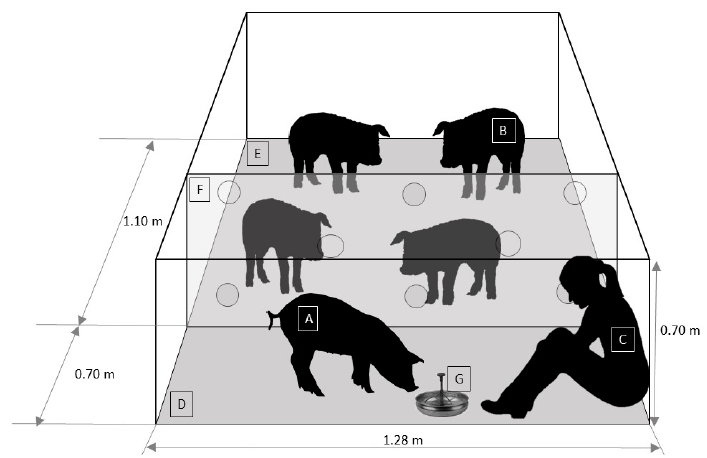
Figure 1. Schematic representation of the pen (front view) during the gentle handling session. A: demonstrator pig (dominant or subordinate), B: observer pig, C: stockperson, D: demonstrator pig handling area, E: observer pig area, F: transparent acrylic panel, G: drinker bowl with 16% sucrose solution.